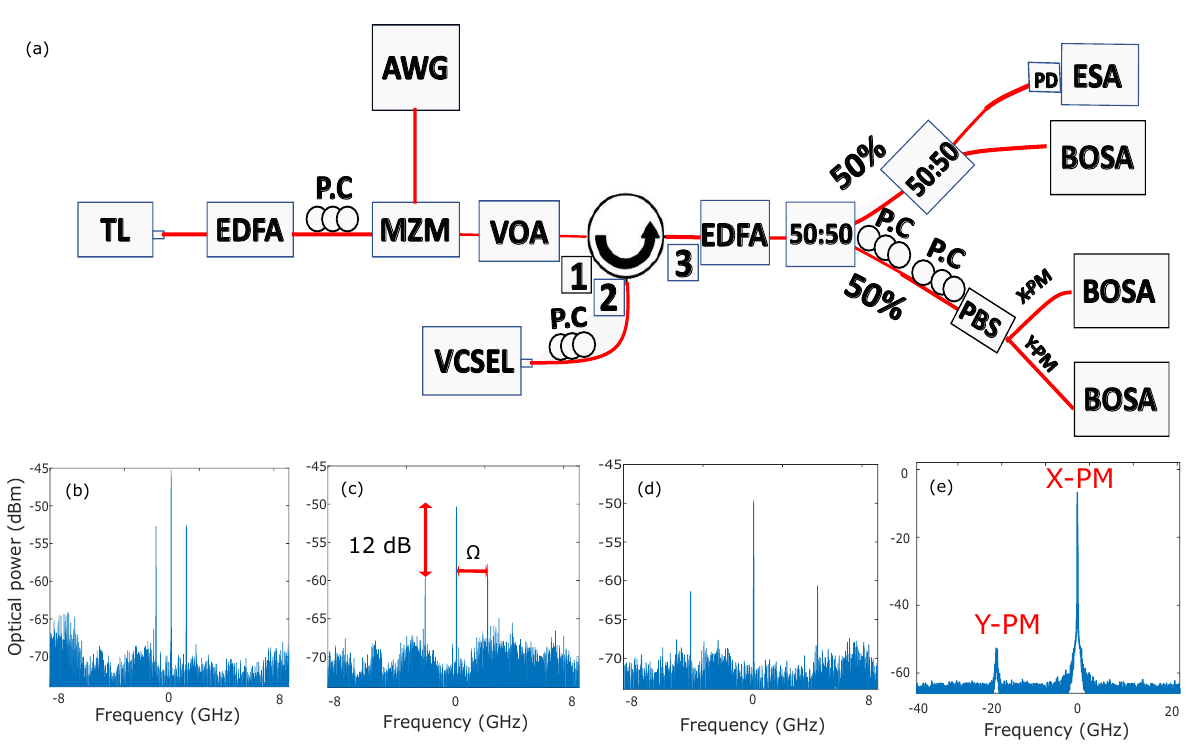
Figure 1. ( a ) Setup for frequency comb injection into a single-mode VCSEL. TL: Tunable Laser, EDFA: amplifier, P.C: Polarization Controller, AWG: Arbitrary Waveform Generator, MZM: Mach– Zehnder Modulator, VOA: Variable Optical Attenuator, OSA: Optical Spectrum Analyser, PD: photo- diode, ESA: Electrical spectrum analyzer. ( b – d ) correspond to the optical spectra of the injected comb for comb spacing of Ω = 1 GHz, Ω = 2 GHz and Ω = 4 GHz, respectively. ( e ) shows the optical spectrum of the VCSEL in free